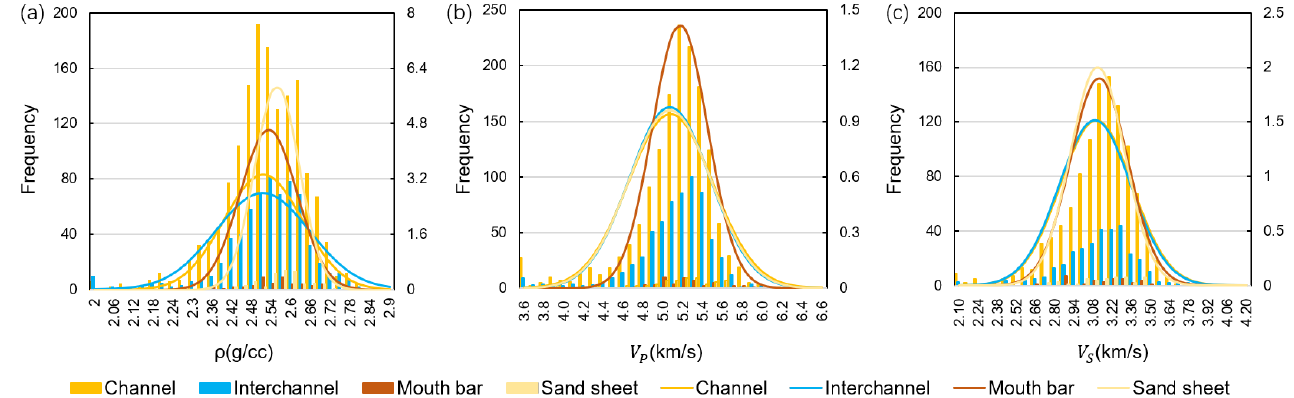
Figure 12. Statistical diagram showing the relationship between the elastic parameters and the lithofacies.